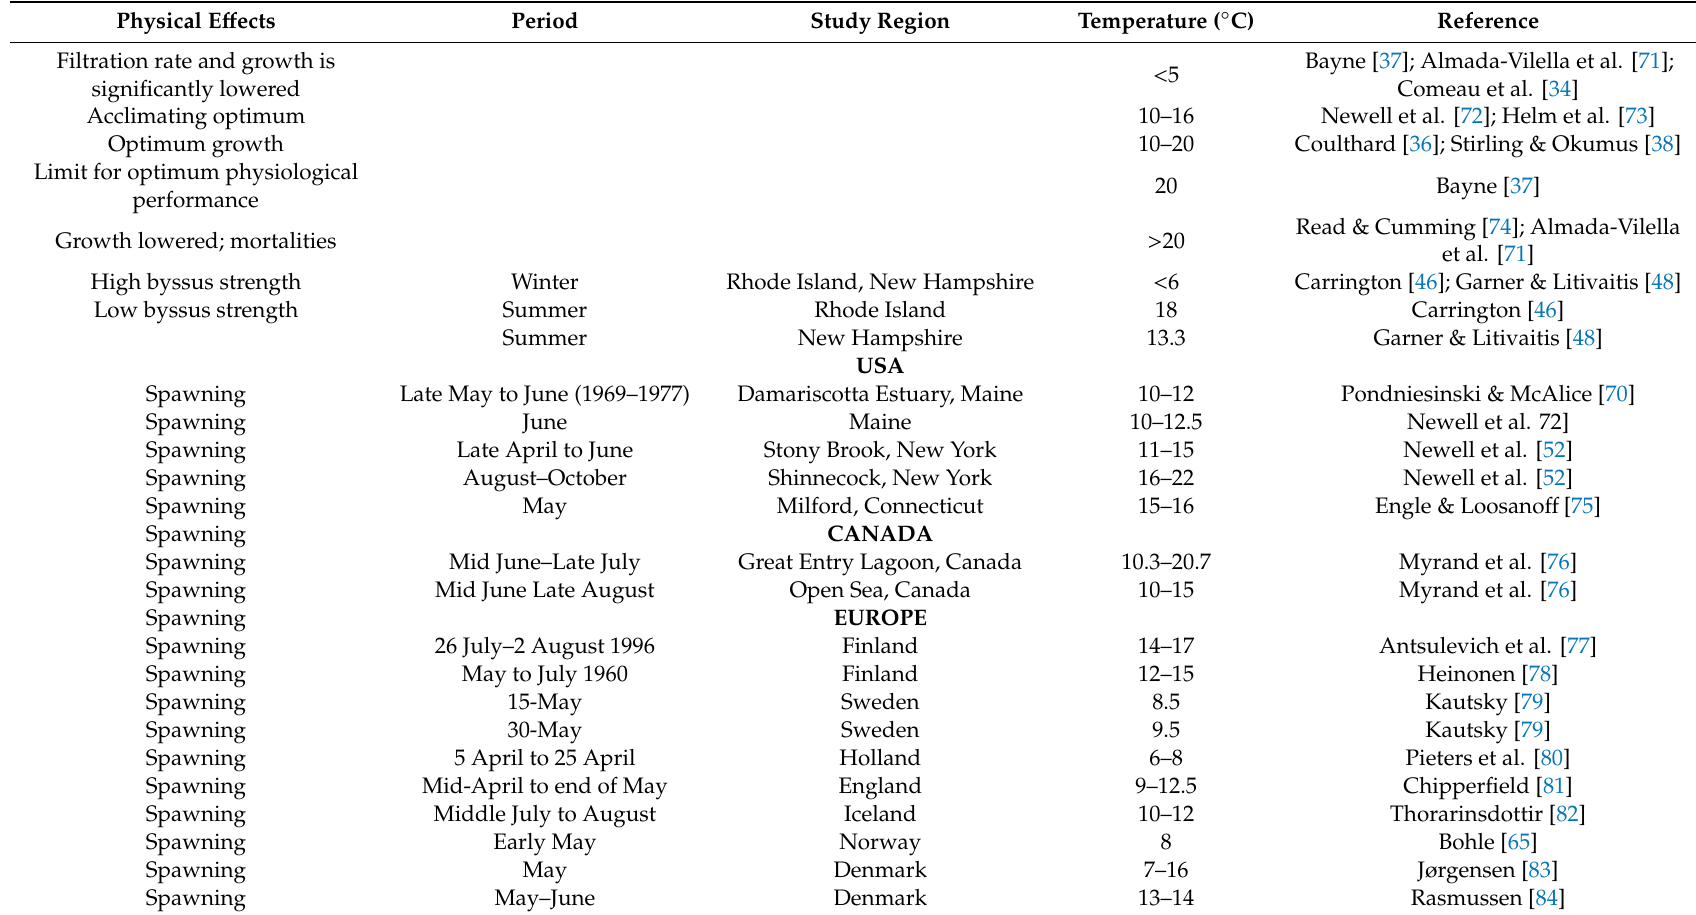
Table 1. Temperature thresholds and related e ff ects on the physiology of blue mussel, Mytilus edulis New table built upon some data from Pondniesinski & McAlice